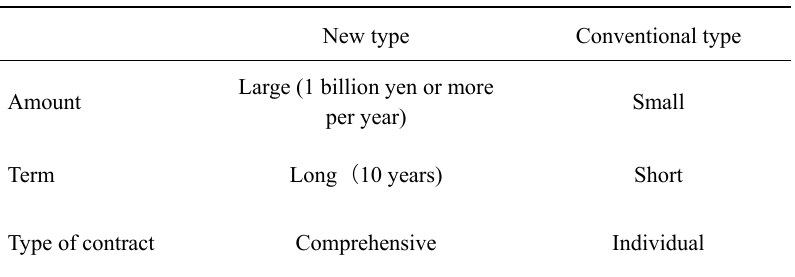
Table 2. Characteristics of the “new type” of